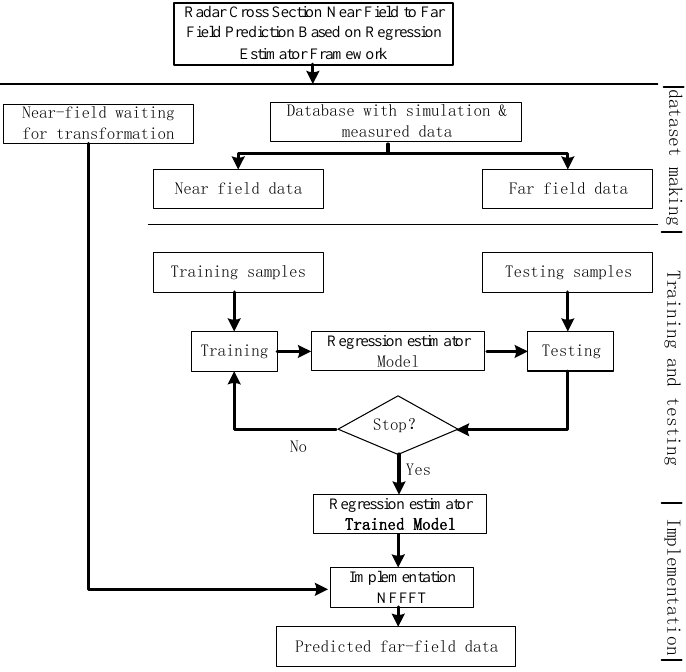
Figure 3. Near-field to far-field transformation framework flow chart.